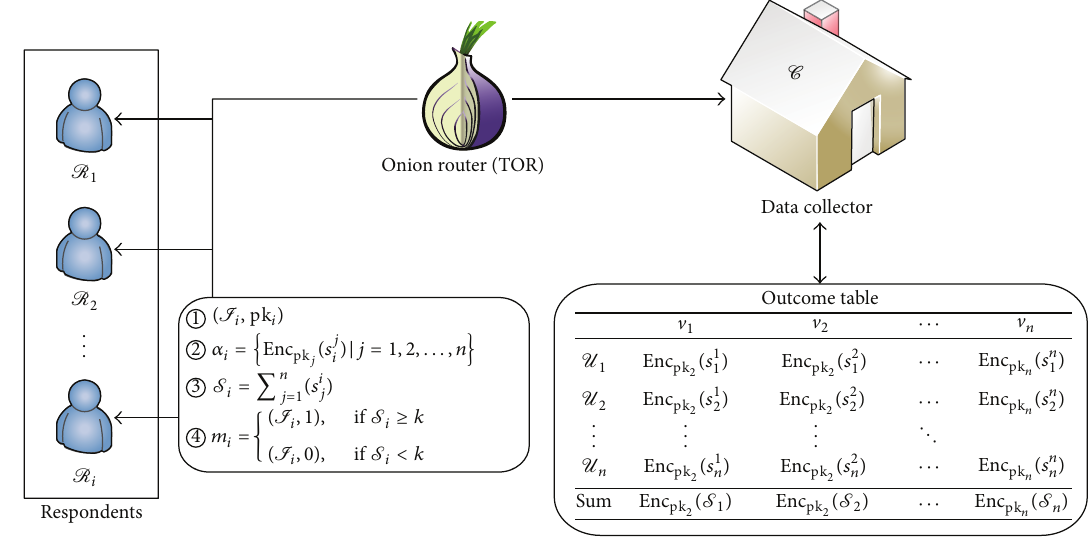
Figure 1: Overview of the proposed solution.